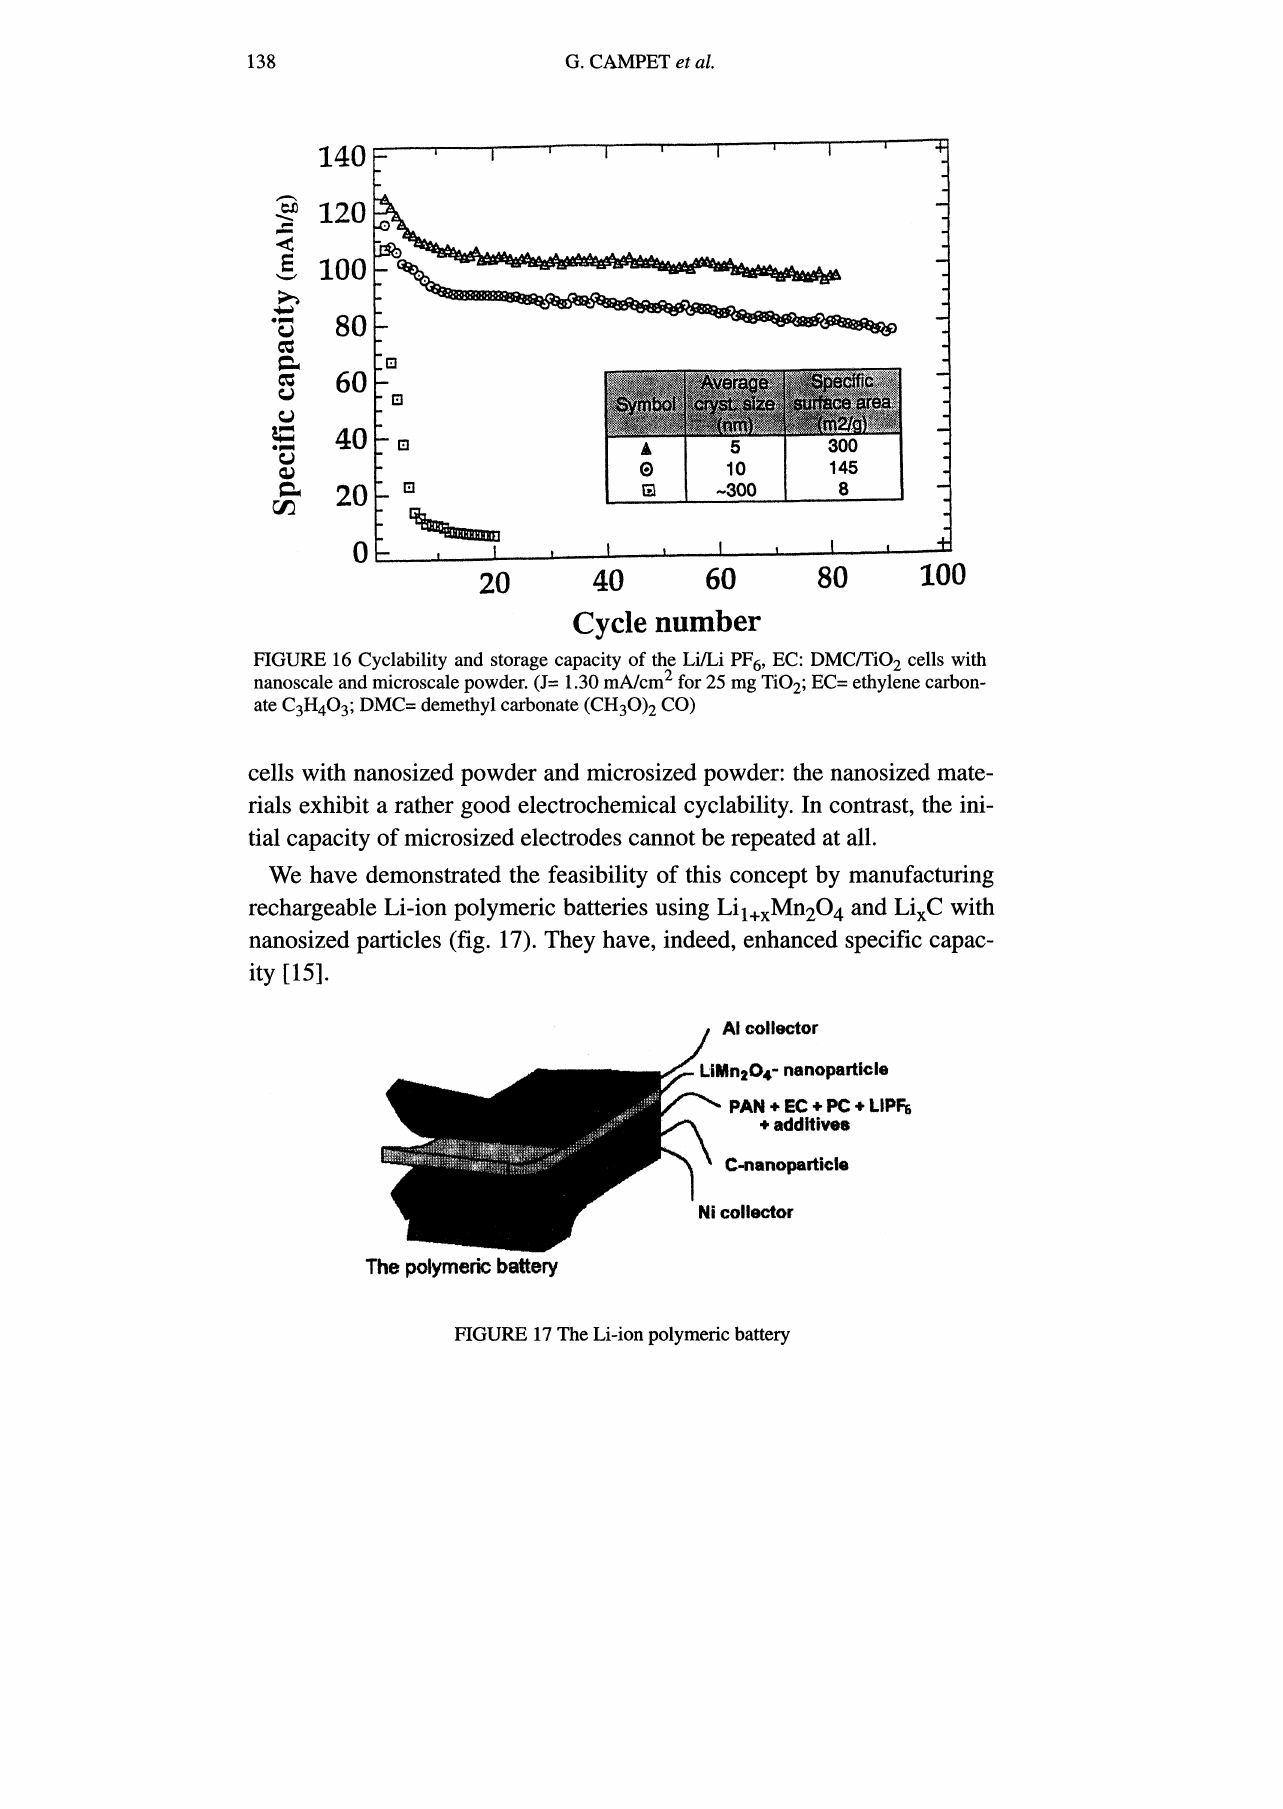
FIGURE 16 Cyclability and storage capacity of the Li/Li PF 6, EC: DMC/TiO 2 cells with nanoscale and microscale powder. (J= 1.30 mA/cm 2 for 25 mg TiO2; EC= ethylene carbon- ate C3H403; DMC= demethyl carbonate (CH30)2 CO)